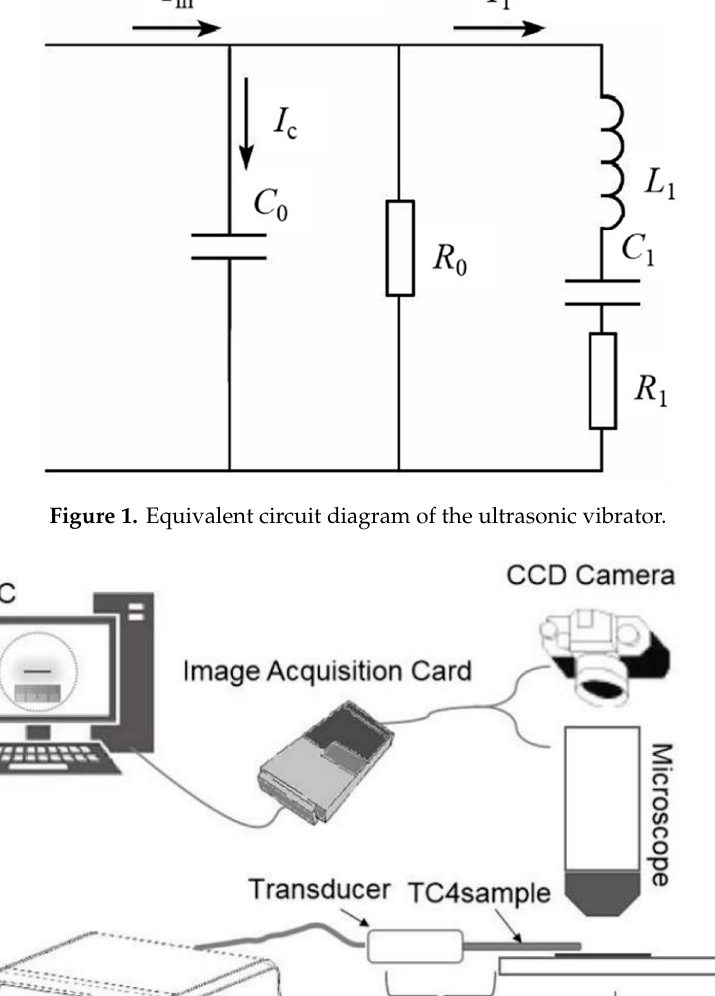
Figure 1. Equivalent circuit diagram of the ultrasonic vibrator.